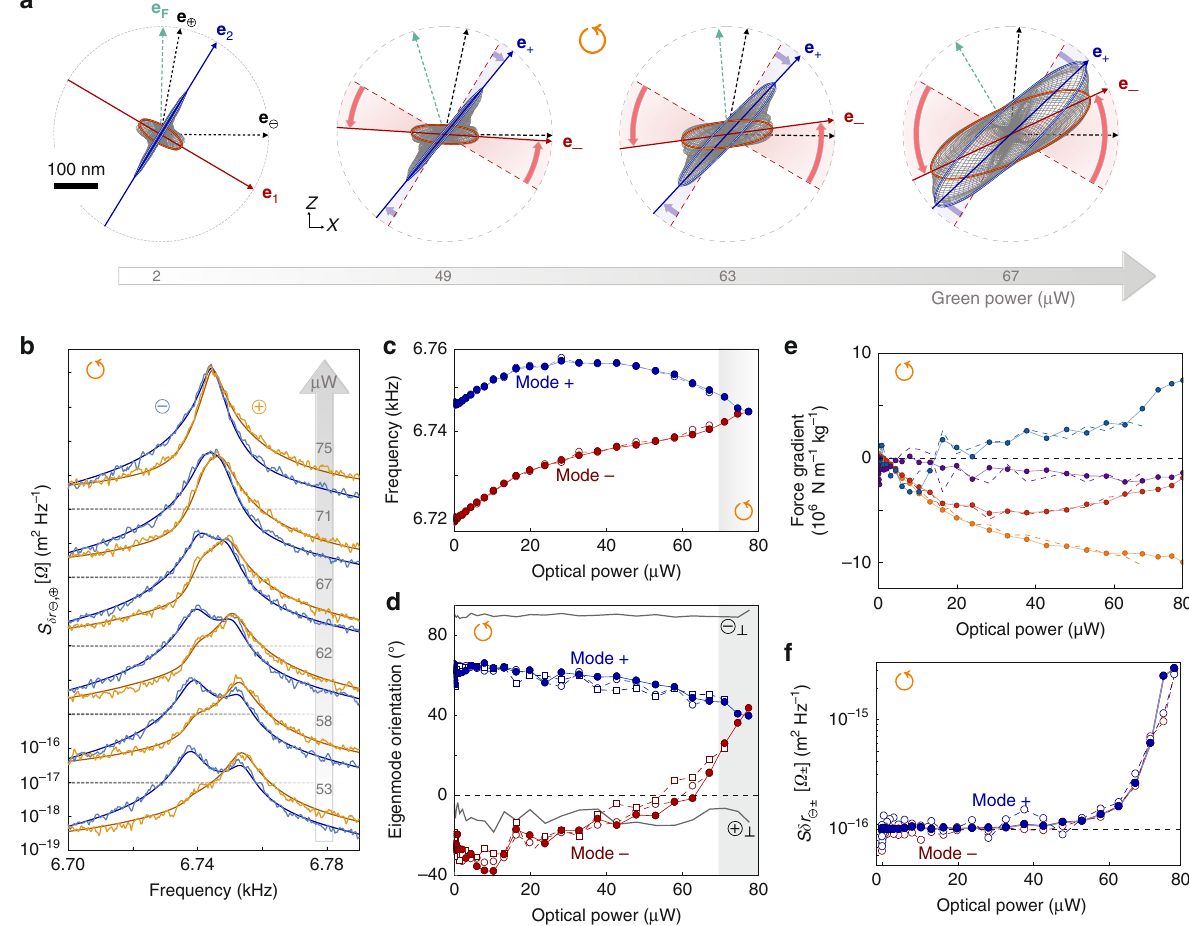
Fig. 2 Eigenmodes warping. a Driven trajectories in the XZ plane (gray curves) for increasing static green power but constant driving amplitude. The resonantly driven trajectories at Ω + / − are highlighted in blue/red. Eigenmodes orientations e ± lose their initial orthogonality and converge towards each other. Also shown are the measurement vectors e (cid:2) ; (cid:3) and the drive orientation ( e F ), while the eigenmodes rotation is highlighted by shaded red/blue areas. b Thermal noise spectra (solid light lines) measured for increasing green power (with a 2-decades vertical offset between each set). Solid dark lines are fi ts using the equation of S δ r ½ Ω (cid:7) derived from the model. c , d Evolution of eigenfrequencies Ω ± /2 π and eigenmodes orientations θ ± with the green optical (cid:2) ; (cid:3) power. Angles derived from resonant analysis 17 of thermal noise spectra/driven trajectories are marked as open circles/squares. Filled symbols are deduced from the force fi eld gradients used to fi t the thermal noise spectra of panel b , which allow a separate determination of the dressed eigenfrequencies and eigenmode orientations. e Force fi eld gradients ( g 11 orange, g 22 red, g 12 blue, and g 21 violet) deduced from thermal noise spectral analysis (full circles) and from the determined eigenfrequencies shifts and eigenmodes rotations shown ( c , d ) (solid lines) using the inversion relation given in the Supplementary Note 4. f Noise spectral densities S δ r ½ Ω ± (cid:7) deduced from thermal noise analysis (open circles) and from the model Eq. (2) θ ± ( fi lled circles), using the fi tted force fi eld gradients ( e